Question: What kind of plot is shown here?
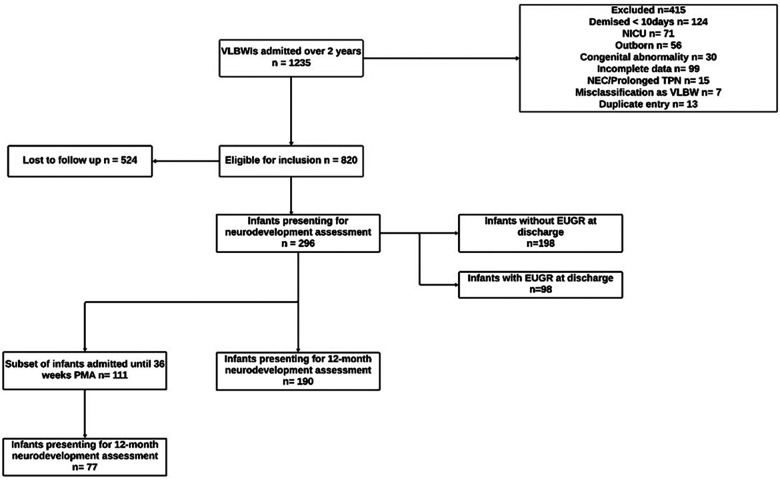
Answer: line